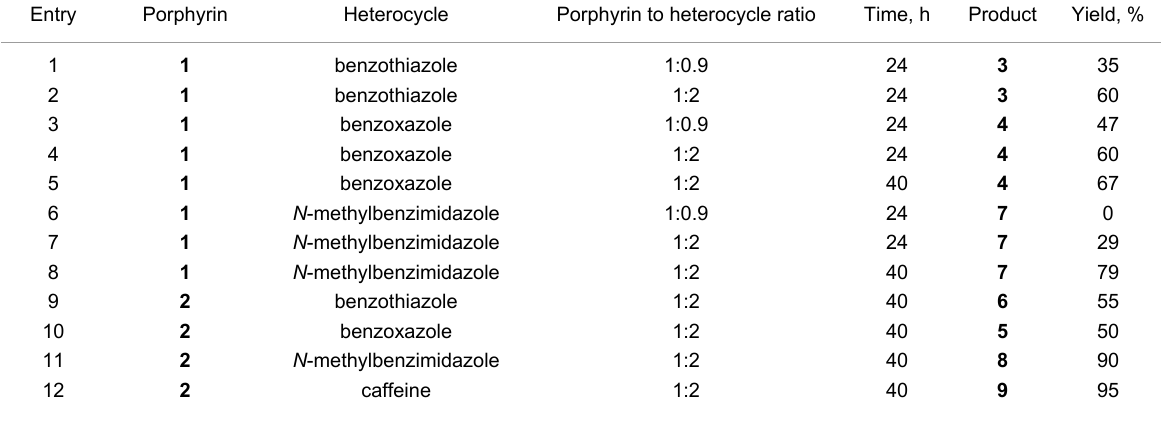
Table 2: Arylation of zinc meso -(bromophenyl)porphyrinates 1 , 2 with benzothiazole, benzoxazole, N -methylbenzimidazole and caffeine (conditions: